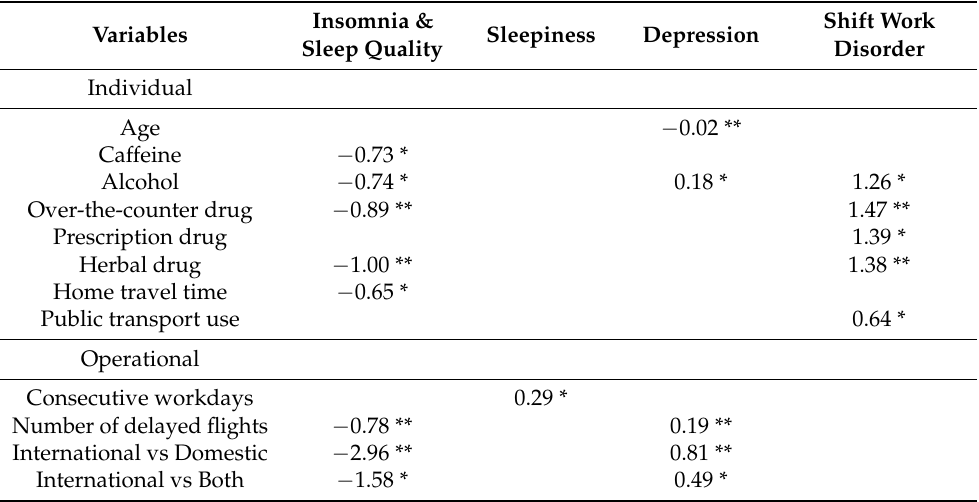
Table 5. Summary of significant beta values and odds ratios for regression analysis predicting insomnia & sleep quality, sleepiness, depression and shift work disorder. Insomnia Variables